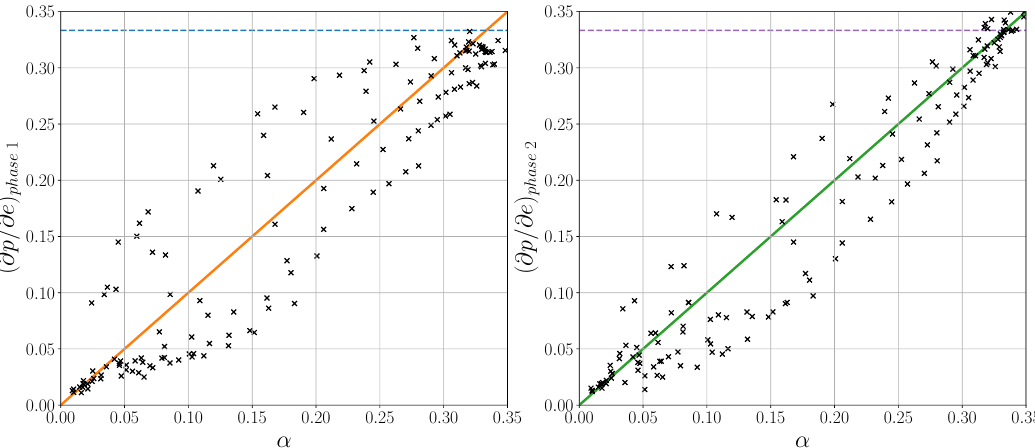
Figure 14 . Scatter plots for the stiffness of the equation of state for phase one (the symmetric phase) on the left and phase two (the broken phase) on the right. The dashed line represents the conformal value ∂p/∂e = 1 / 3 . Density of points is not significant in this plot and is due to how the values of φ M and φ Q were